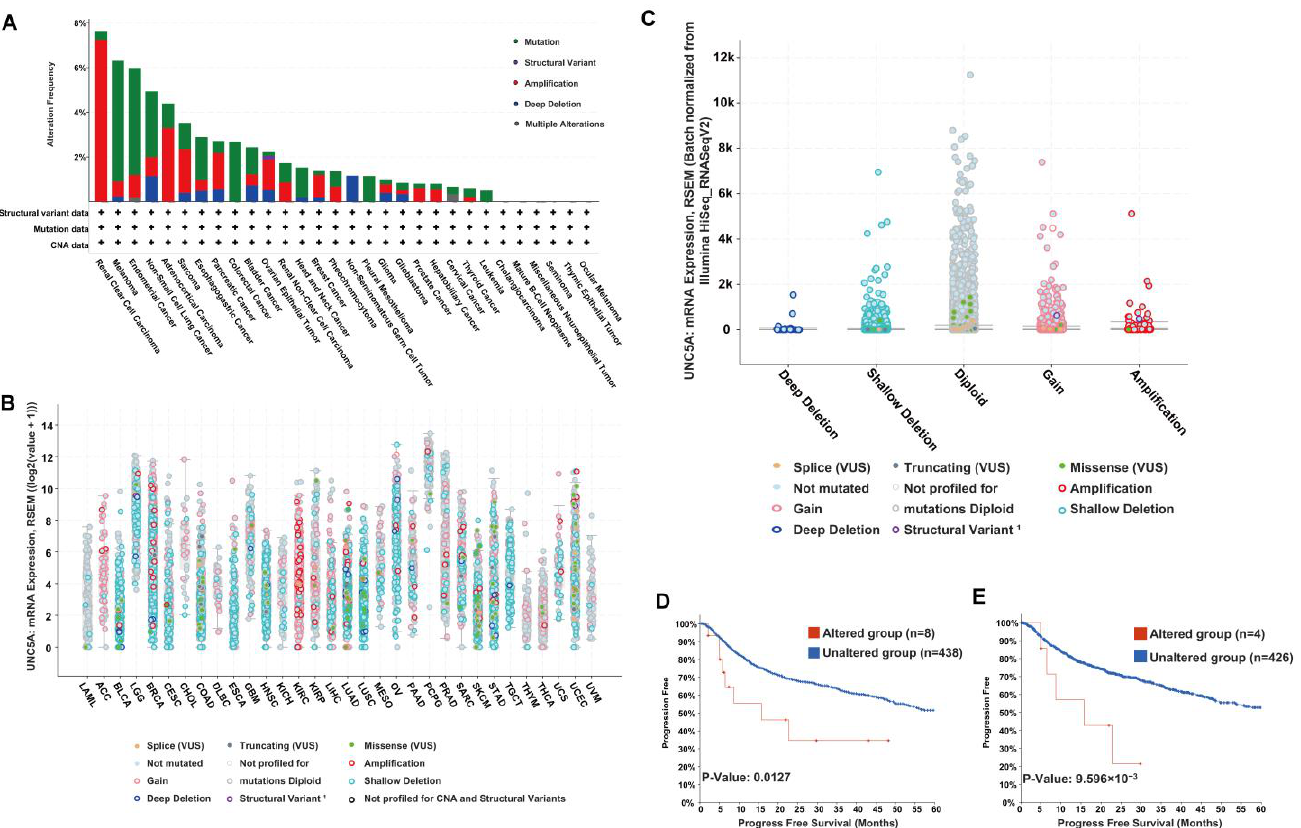
Figure 6. Mutational features of UNC5A in pan-cancer. ( A ) The alteration frequency by mutation type in UNC5A in pan-cancer. ( B ) The major types of UNC5A gene alterations in various cancers. ( C ) The analysis of UNC5A copy number alteration frequencies. ( D ) and ( E ) The relationship between PFS and UNC5A mutational status in HNSC and PRAD, respectively.